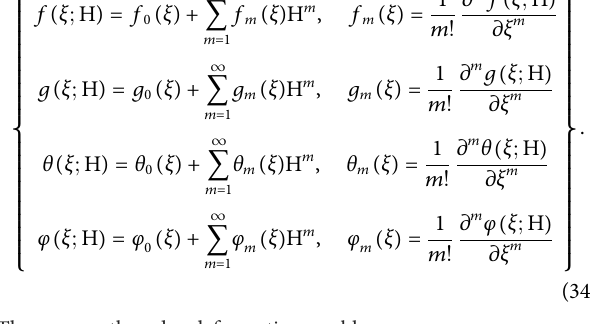
FIGURE 1 Z − curves for f ″ ( 0 ) , g ″ ( 0 ) , θ ′ ( 0 ) , and φ ′ ( 0 )